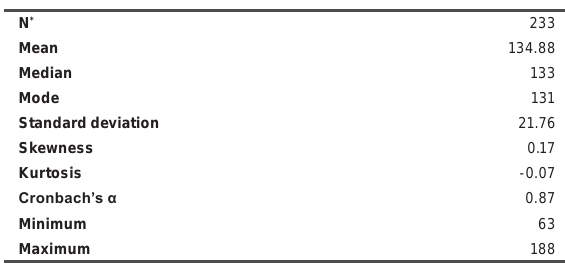
TABLE 5 Descriptive statistics for Sense of Coherence as measured by the Orientation of Life Questionnaire